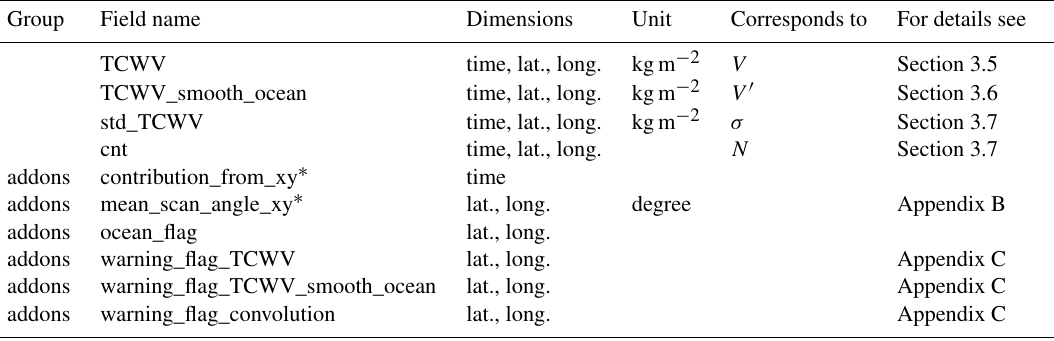
Table 2. Content of the climate product, provided in NetCDF format. Group